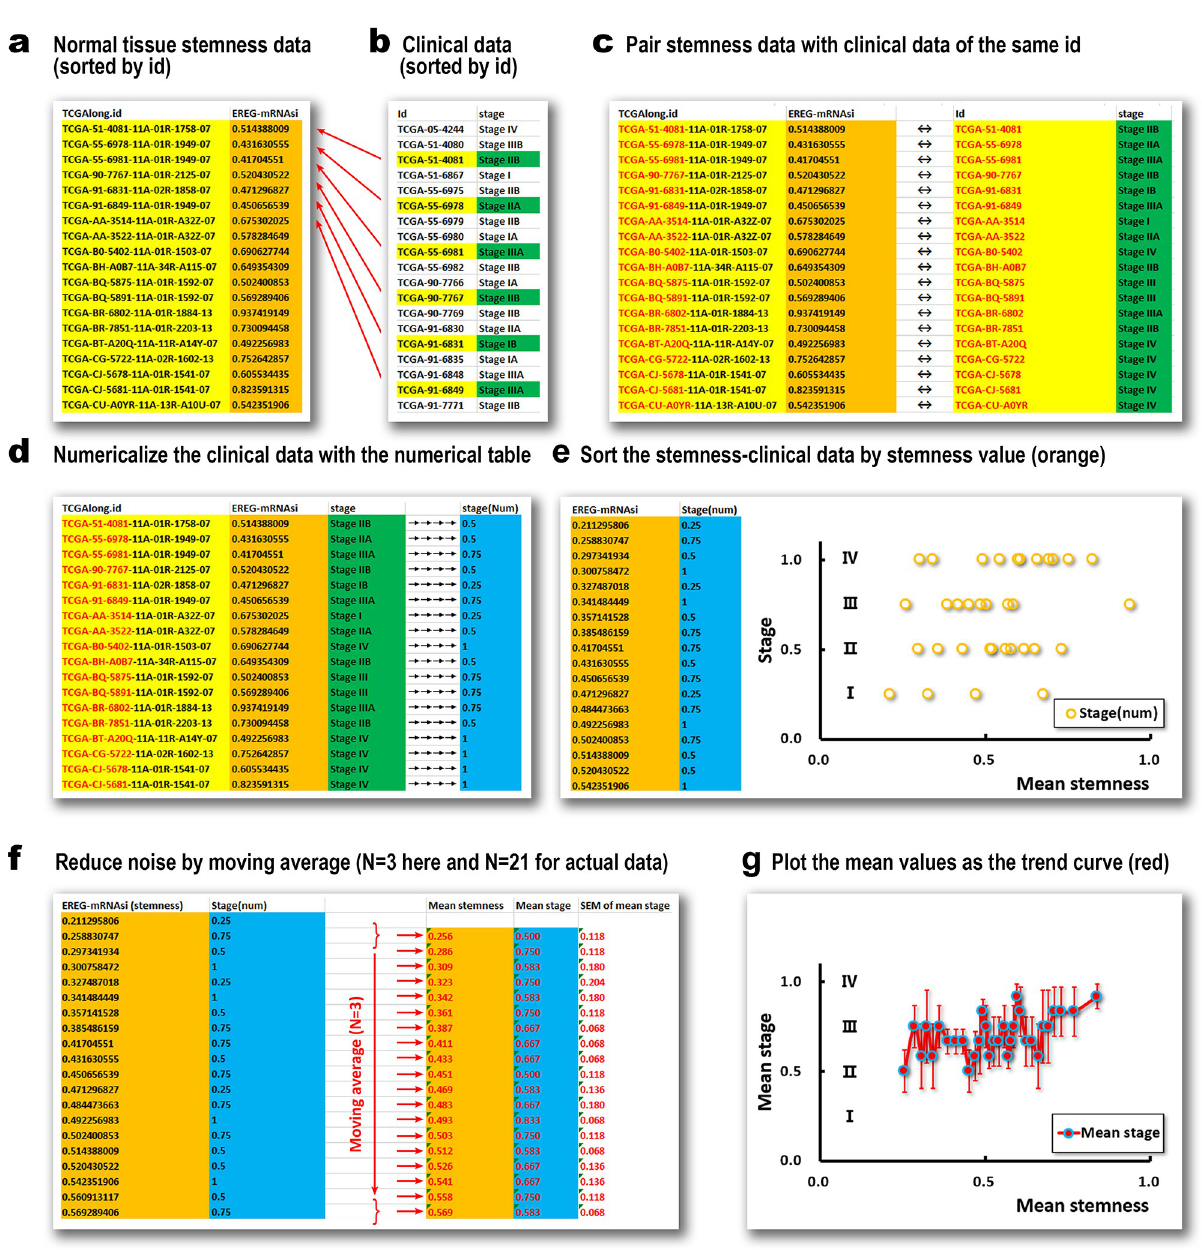
Fig 1. The data mining processes for clinical data (stages as example). We sort all normal solid tissue stemness data (a: EREG-mRNAsi) and clinical data (b: cancer stage) by patient IDs (TCGAlong.id or id) and pair them with the identical IDs (c). With Table 1, we give each stage a numerical value (d) and sort the data (e) by stemness index (EREG-mRNAsi). By moving the average (f: N = 3 here, N = 21 for actual data), we reduce the noise for the stage trend